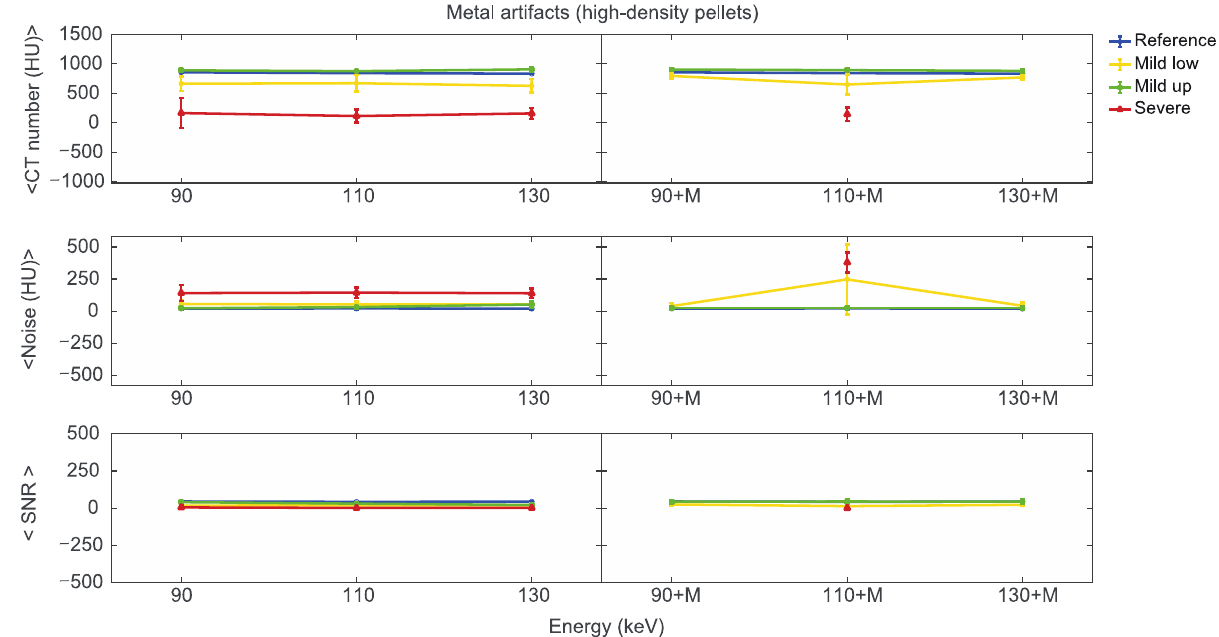
Figure 8. Mean CT number, noise, and SNR for medium ‐ density pellets of classified artifacts as a function of the reconstructed images, i.e., VMI without (90, 110, 130) and with the MARS algo ‐ rithm (90+M, 110+M, and 130+M). The values for mild low, mild up, and severe artifact are re ‐ ported with yellow, green, and red lines, respectively. The reference values are indicated with a blue line.